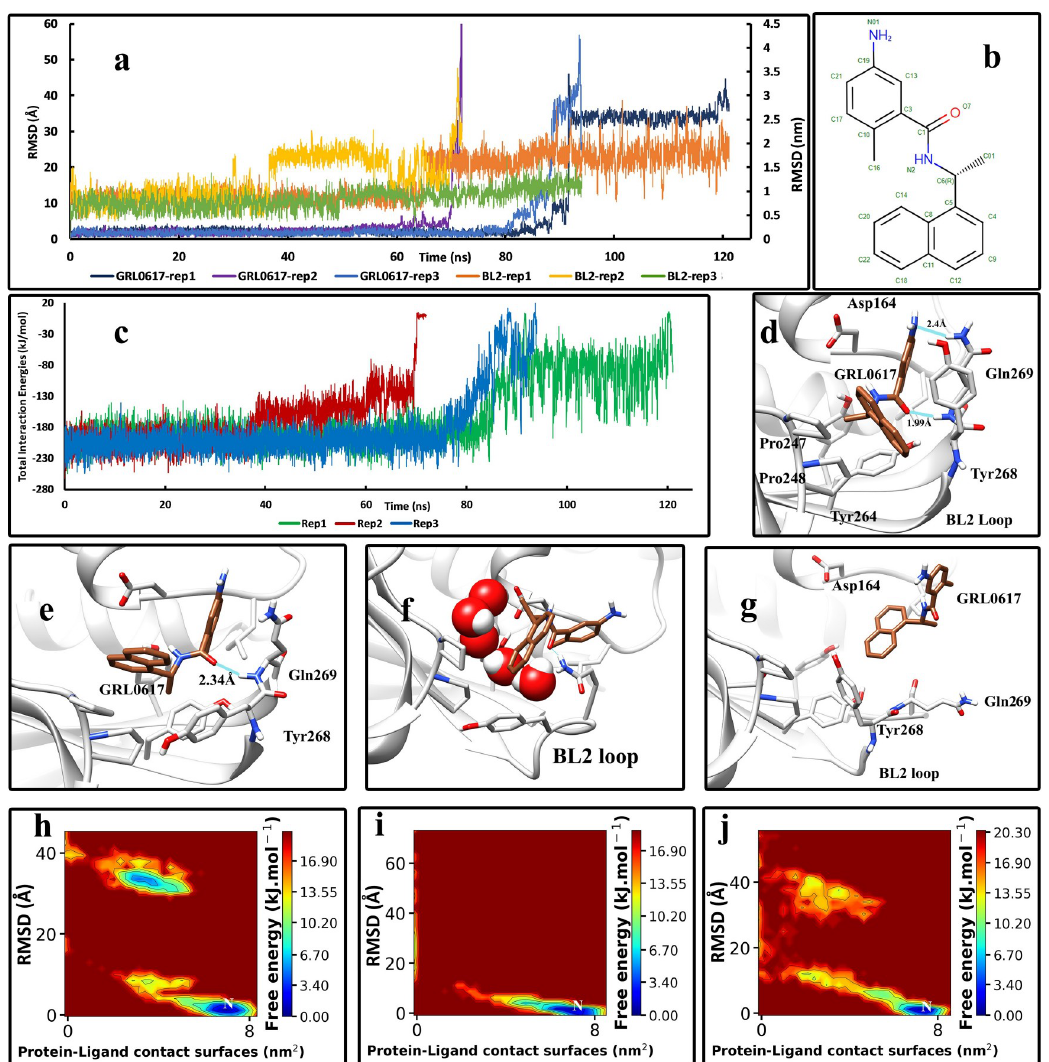
Fig 2. The details of the unbinding pathway of GRL0617 in three series of replicas. (A) The RMSD values of the inhibitor in three replicas (Displayed in Å ) and the backbone RMSD values of residues of the BL2 loop in three replicas (Displayed in nm) throughout the simulations. (B) The 2D structure of GRL0617 was obtained from PDB. (C) The Total interaction Energies of the protein-ligand complexes throughout the simulations. (D) The native state of the GRL0617 in the crystallographic conformation and the interactions with the residues of the binding pocket (frame at 0 ns). (E) An intermediate state of GRL0617 in the unbinding pathway where the Tyr268 residue forced the inhibitor to change its native conformation (2 nd replica, frame in 68 ns). (F) In another intermediate state, the entire molecule is lifted, and almost all essential bonds and interactions between the ligand and the residues are water-mediated and broken (3 rd replica, frame in 85 ns). (G) The unbound state of the inhibitor is entirely free and solvated in the simulation box (1 st replica, frame in 100 ns). (H) The free energy landscape (FEL) representation of the unbinding pathway of the GRL0617, replica No 1. (I) The free energy landscape (FEL) representation of the unbinding pathway of the GRL0617, replica No 2. (J) The free energy landscape (FEL) representation of the unbinding pathway of the GRL0617, replica No 3. Letter “N” indicates the native crystallographic conformation.